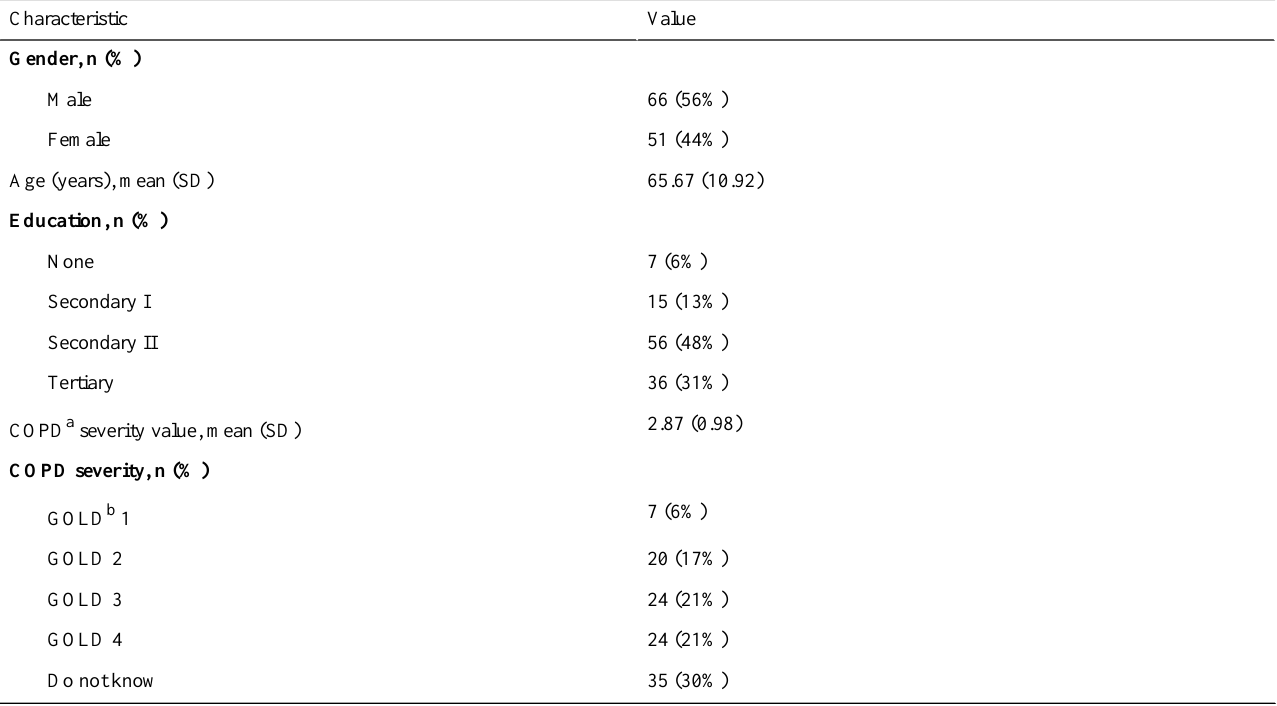
Table 1. Descriptive statistics of the participants in Study 1